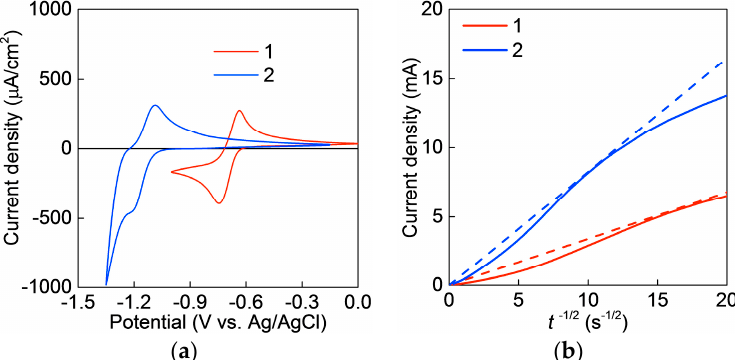
Figure 2. ( a ) Cyclic voltammograms for thin layers of 1 and 2 . Scan rate was 50 mV/s; ( b ) Cottrell curves for 1 and 2 . A potential pulse from − 1.2 to 0 V vs. Ag/AgCl was applied. 1 M LiTFSI aqueous solution was used as electrolytes.